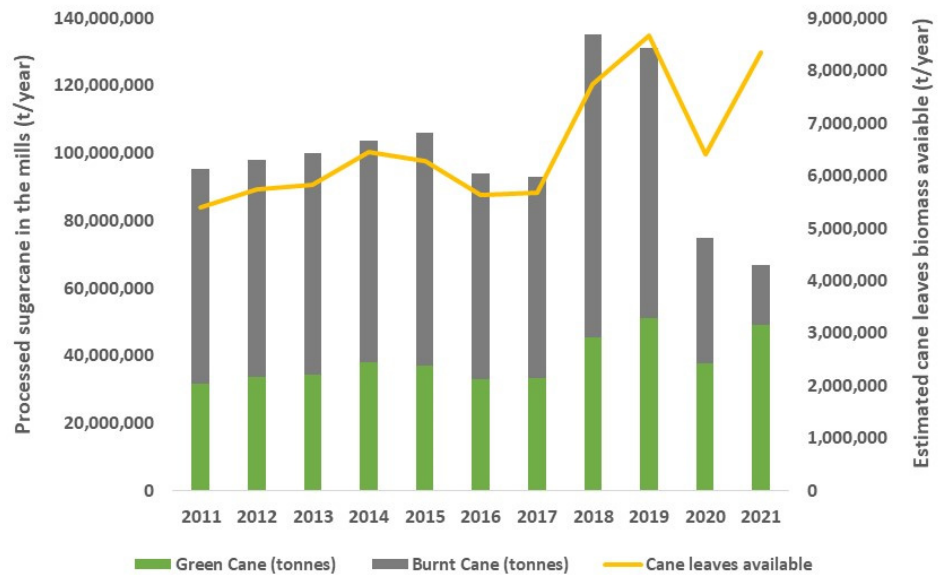
Figure 4. The share between green and burnt cane in the Thai sugarcane industry and the estimated availability of cane leaves and trash.